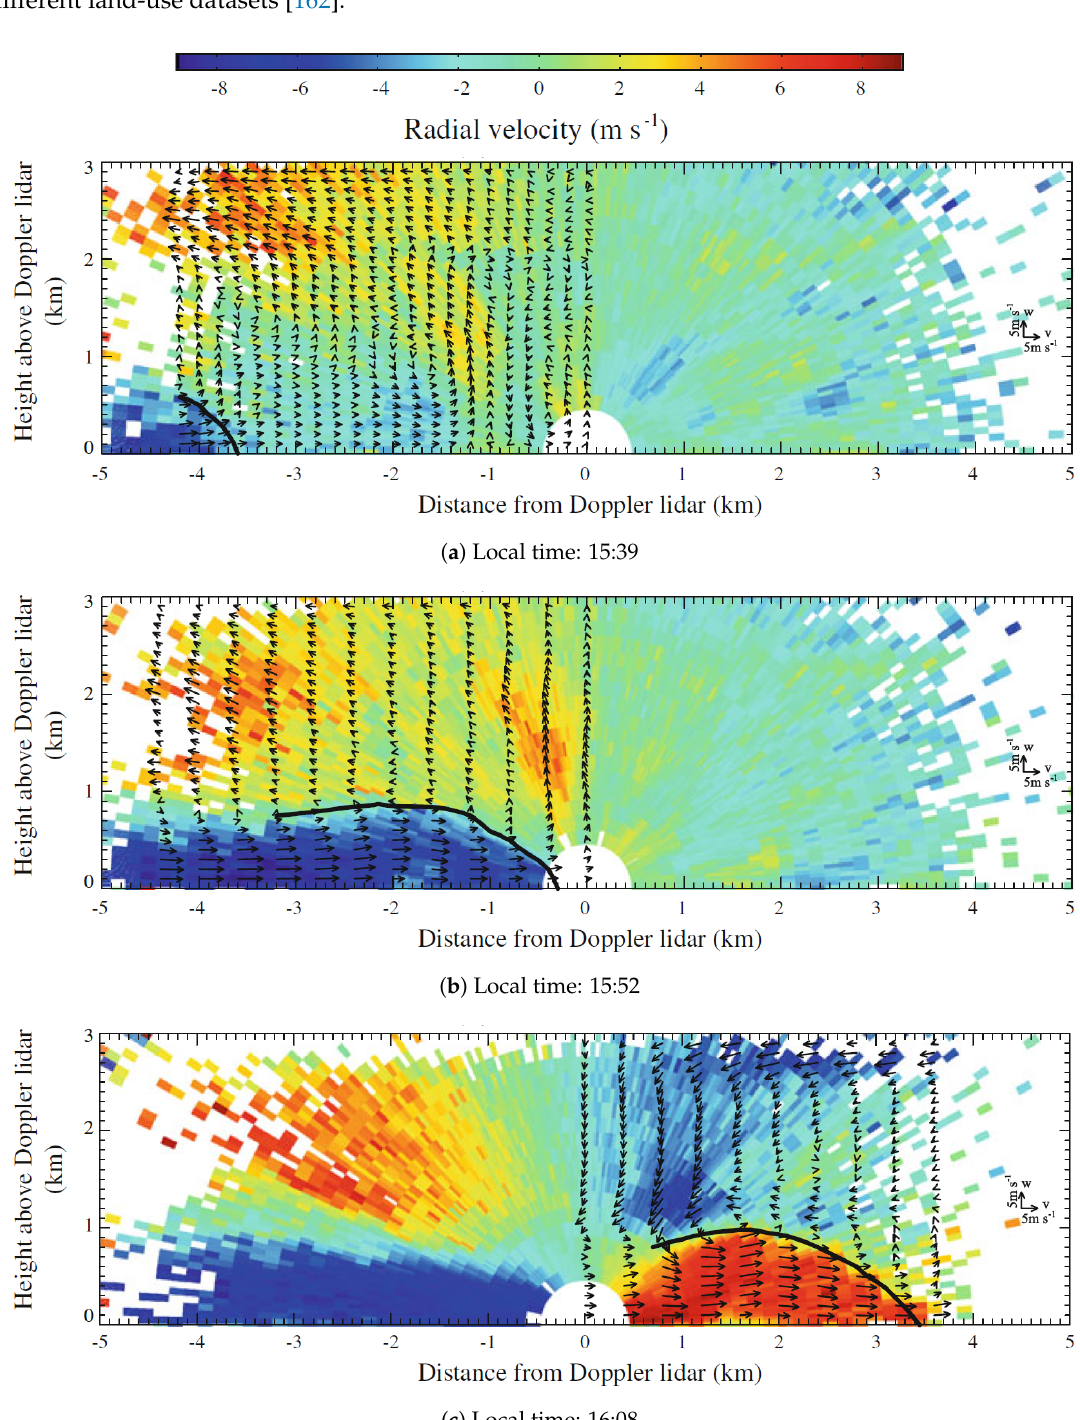
Figure 11. Plots of radial velocity measured by a Doppler LiDAR located at the origin of the Cartesian coordinate system [161]. Black arrows represent the retrieved velocity vectors. The thick black lines are boundaries estimated by location of the maximum gradient of the radial velocity in the azimuthal